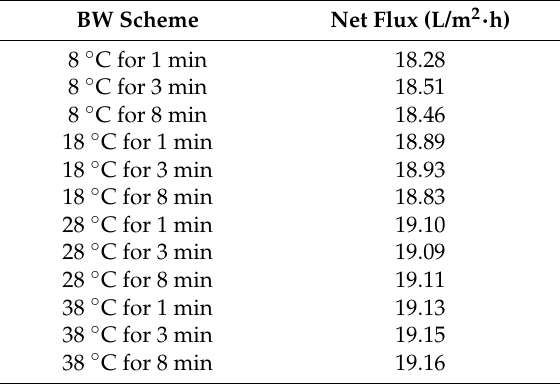
Table 3. Net flux (L/m 2 ·h) of all the different BW scheme for a weekly operation.